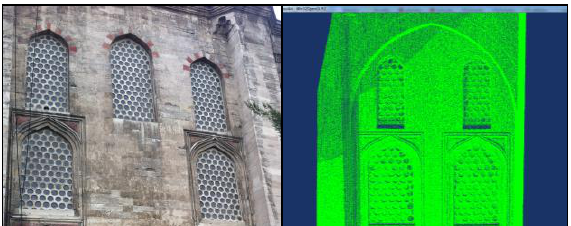
Figure 5. A sample of façade element with different window design elements seen in the image and relevant point cloud.